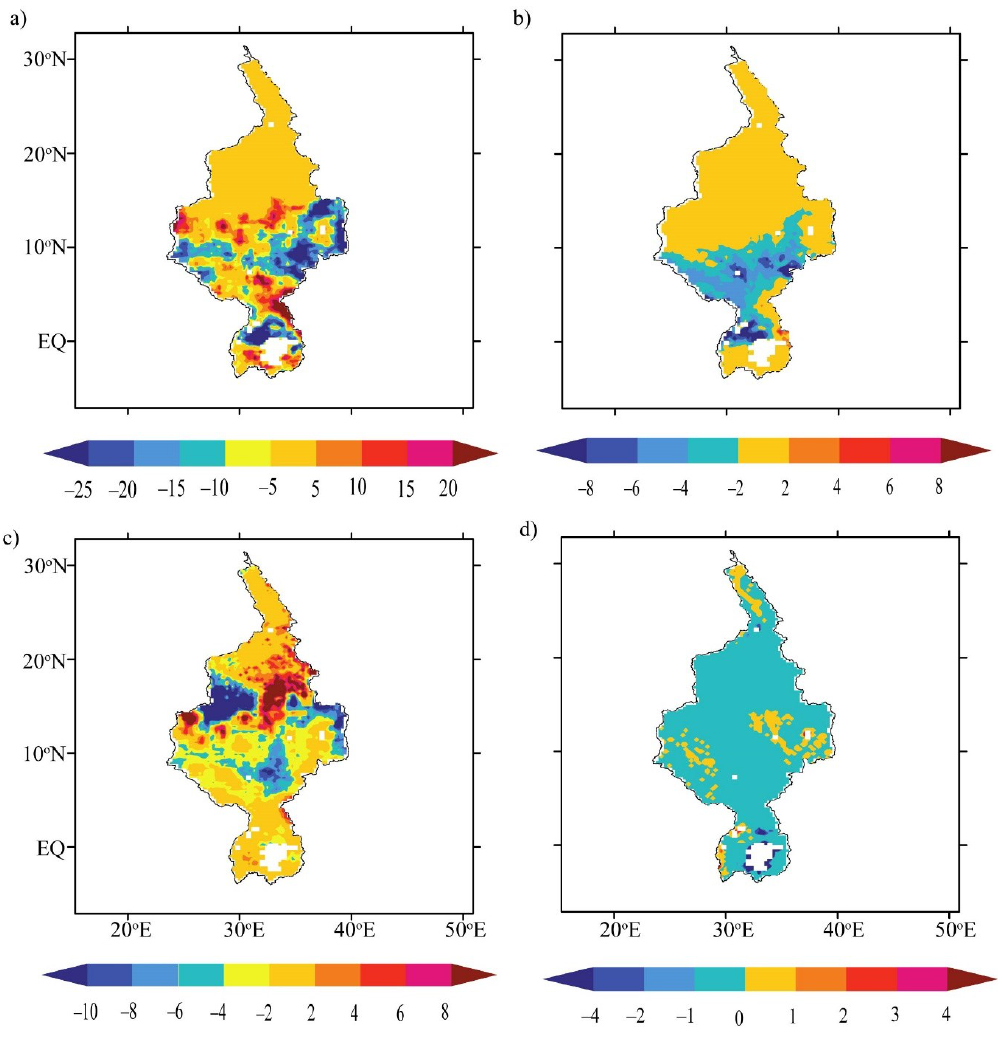
Figure 10. Spatial distributions of linear trends of each ET component in the Nile Basin for the period 1980–2014: ( a ) E b , ( b ) E i , ( c ) E t , and ( d ) E w .